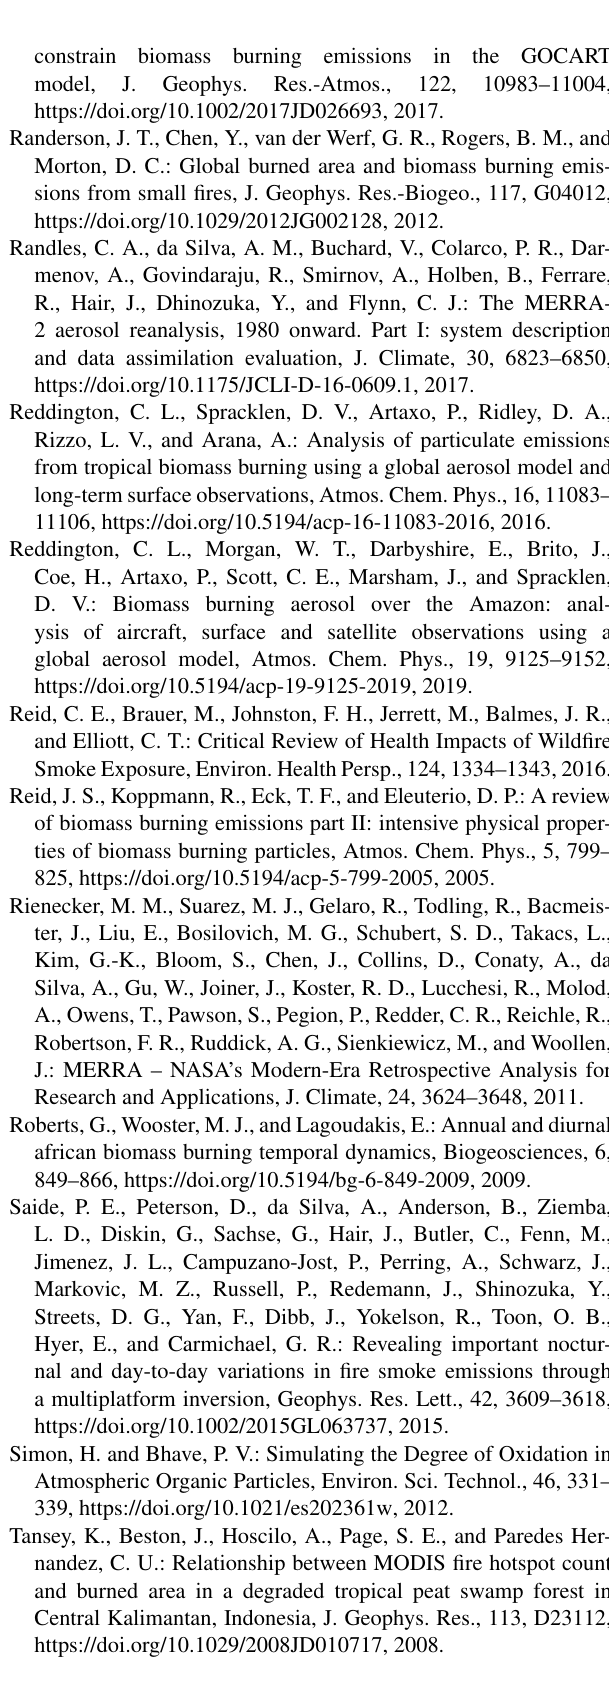
table, last access: 17 January